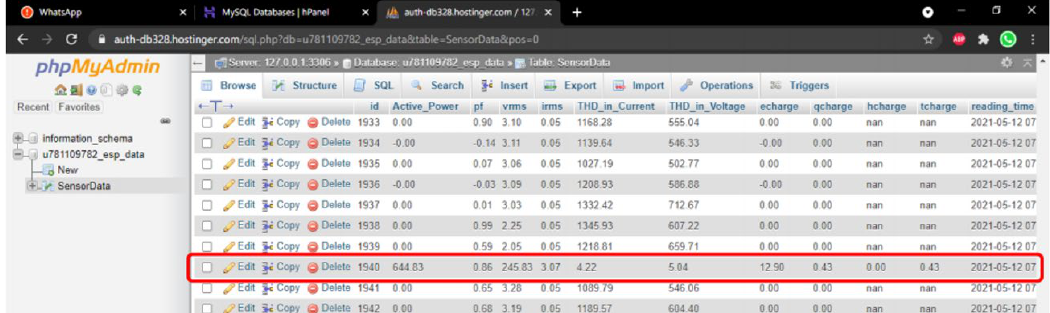
Figure 16. Measurements and penalties of three different loads: an ( a ) incandescent lamp, ( b ) elec- tric iron box, and ( c ) laptop charger.